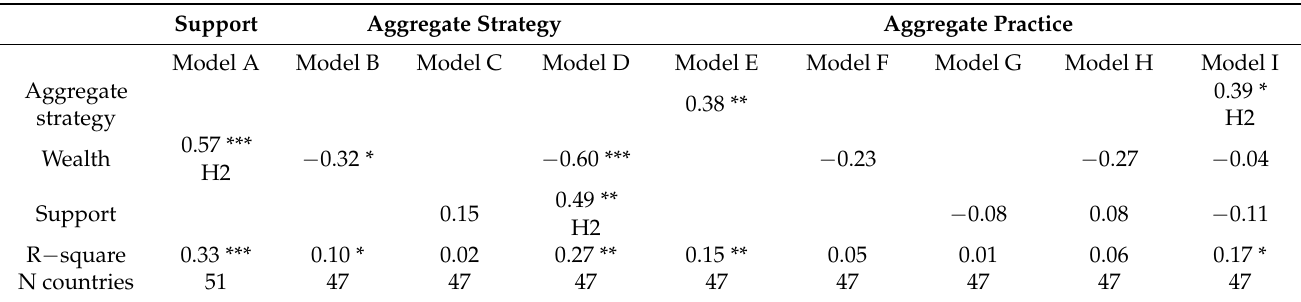
Table 9. Strategy and practice, affected by the national eco-system.